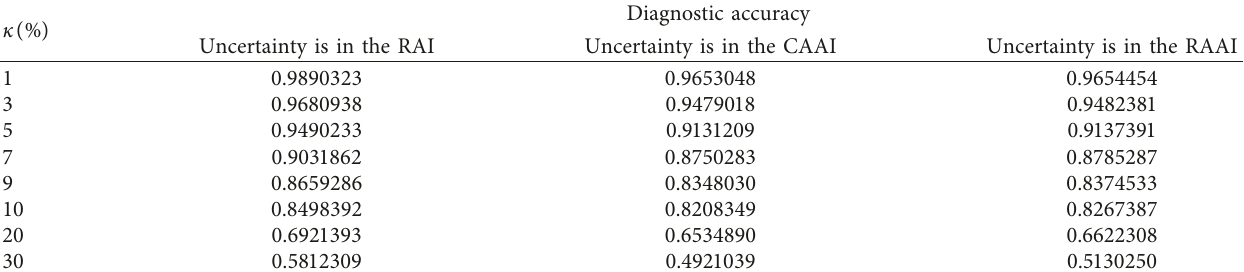
Table 7: Diagnostic accuracy of the proposed method of the IEEE 118-bus system for different κ